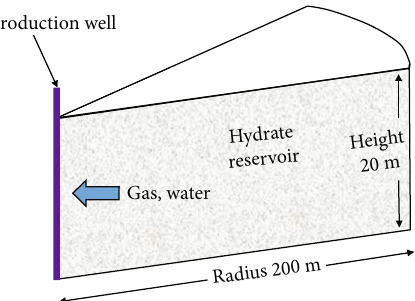
Figure 6: Schematic model of the methane hydrate production